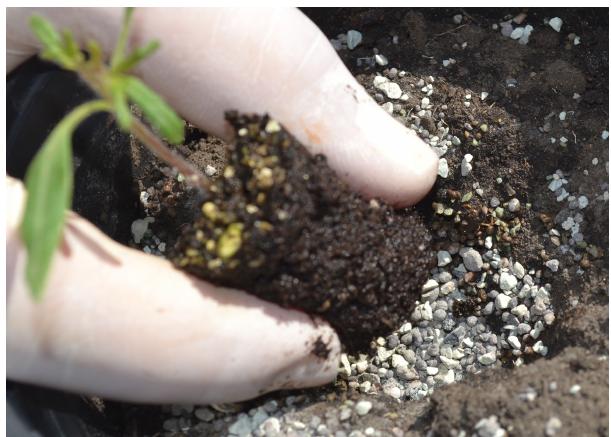
Figure 5. Mycorrhiza supplement in the form of grey aggregates used during tomato